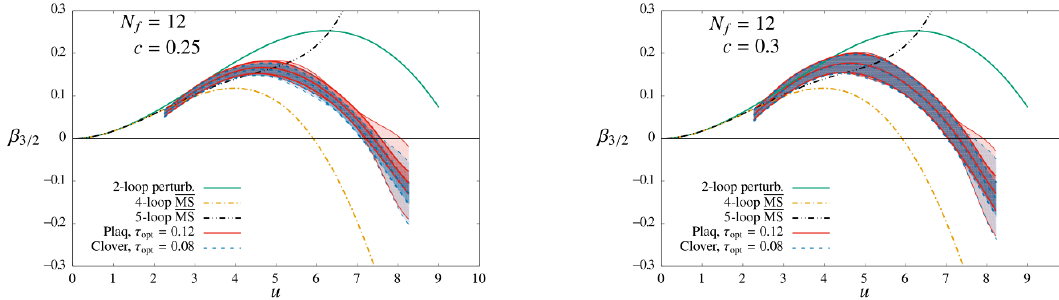
Figure 4 . Continuum-extrapolated discrete (cid:12) function for scale change s = 3 = 2 with c = 0 : 25 (left) and 0.3 (right). In each plot we include both the plaquette (solid red) and clover (dashed blue) discretizations of E ( t ) using the optimal (cid:28) (plaq) = 0 : 12 and (cid:28) opt = 0 : 08, respectively, as well opt as two-loop perturbation theory (solid line) and the four- and (cid:12)ve-loop perturbative predictions in the MS scheme (dash-dotted and dash-double-dotted lines, respectively). Both gradient (cid:13)ow renormalization schemes indicate an IR (cid:12)xed point at g 2 = 7 : 26. The darker error bands indicate ? statistical uncertainties, while the lighter error bands show the total uncertainties, with statisti- cal and systematic errors added in quadrature. Although the systematic errors are symmetrized, (cid:12)gure 2 shows that at strong coupling the larger lattice volumes would produce results for (cid:12) s farther below zero, reinforcing the existence of the IR (cid:12)xed